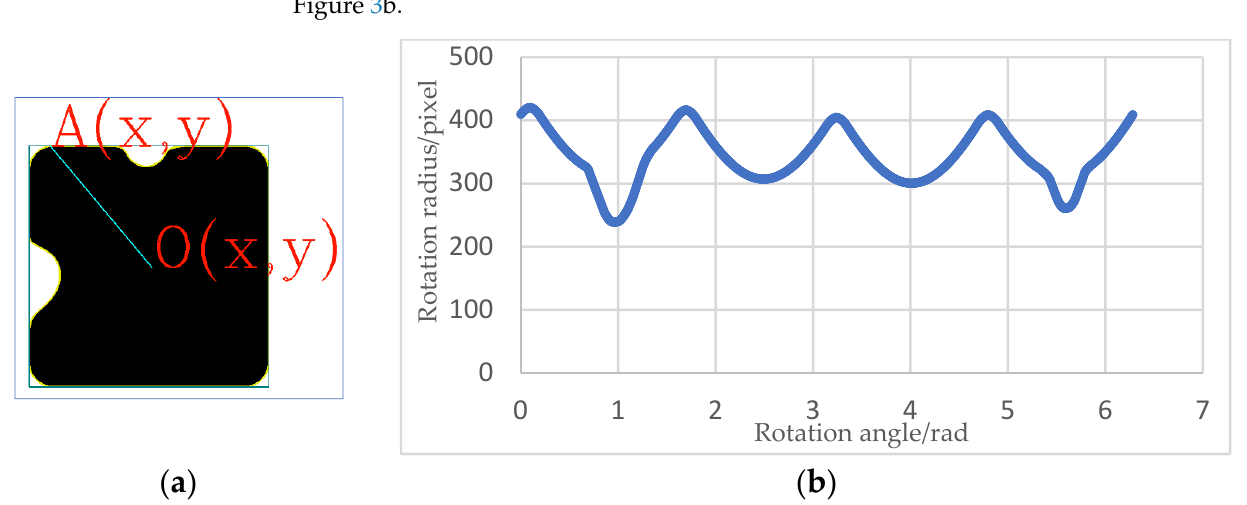
Figure 2. Graphical radius of round workpiece. ( a ) Round piece, ( b ) Curve graph. For an irregular workpiece, as shown in Figure 3a, O ( x, y ) is the center of mass of the irregular workpiece, A ( x, y ) is a point on the contour of the workpiece, and | OA | is one radius of the workpiece. With point O as the center of rotation, starting from point A, the rotation is 360 degrees, and each radius is expanded in an orderly manner, and the workpiece contour is a curved contour with interlaced peaks and valleys, as shown in Figure 3b.